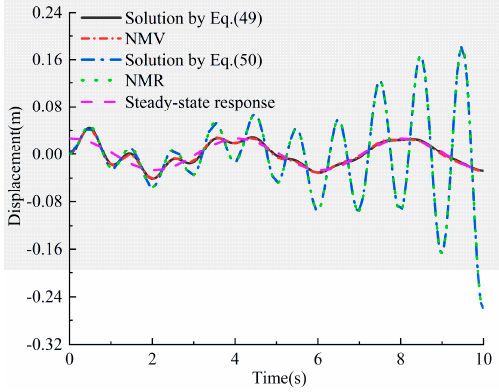
Figure 2. Forced vibration solution with harmonic force.